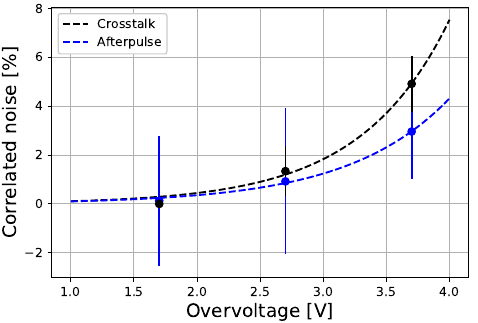
Figure 10. SiPM crosstalk (black line) and afterpulsing (blue line) depending on the over-voltage. The correlated noise dependency on temperature was analyzed by performing after- pulsing and crosstalk measurements from 0 ◦ C to 40 ◦ C at 56 V. At 0 ◦ C, the probability of afterpulsing is below 2% and of crosstalk is below 4%. The afterpulsing increases faster than crosstalk with temperature, rising up almost 5% at 40 ◦ C while crosstalk reaches